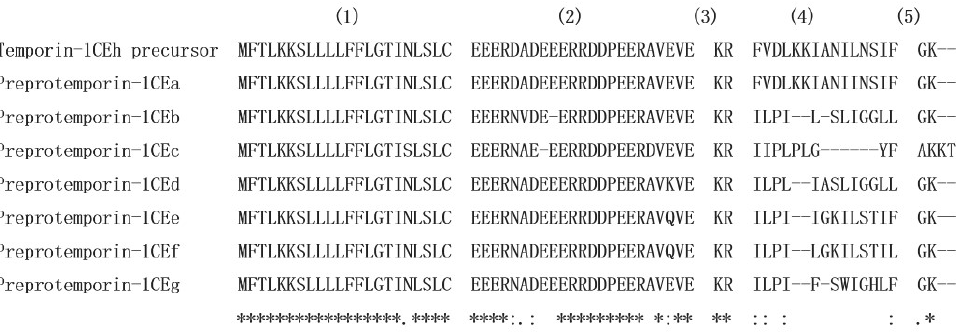
Figure 2. Alignment of open-reading frame amino acid sequences of Temporin-1CEh precursor, preproTemporin-1CEa, preproTemporin-1CEb, preproTemporin-1CEc, preproTemporin-1CEd,